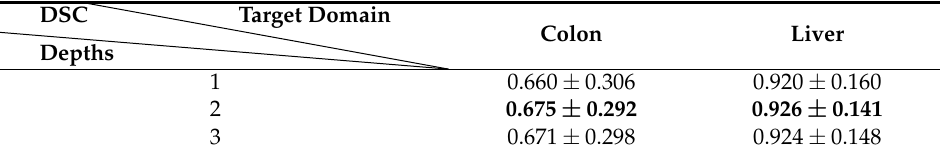
Table 3. The results on the two established segmentation scenarios under different initial freezing depths. The bold values represent the most suitable depths that achieve the best